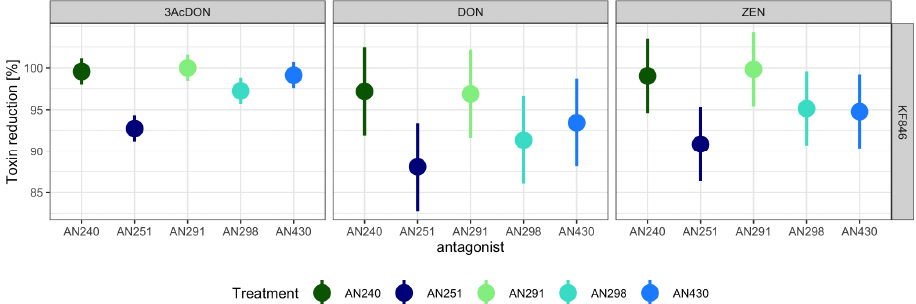
Figure 5. Toxin reduction (%) as a change of 3-AcDON, DON and ZEN content (pathogen-antagonists dual culture) relative to the control culture ( F. culmorum KF846).